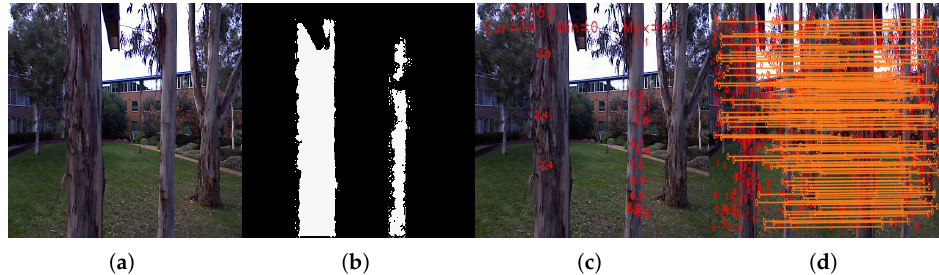
Figure 3. Feature detection and matching process. ( a ) Input image. ( b ) Corresponding depth image. ( c ) Selected image features that have corresponding depths. ( d ) Feature matching between two consecutive images using SURF descriptors followed by